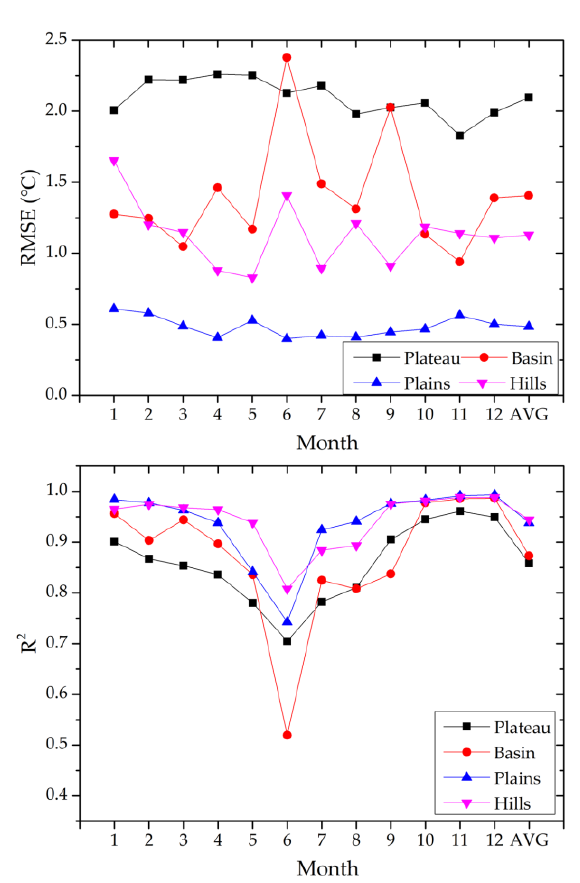
Figure 4 RMSE and R 2 of the predicted monthly mean near surface air temperature using the geographically weighted regression model for varied terrain types in China in 12 months of